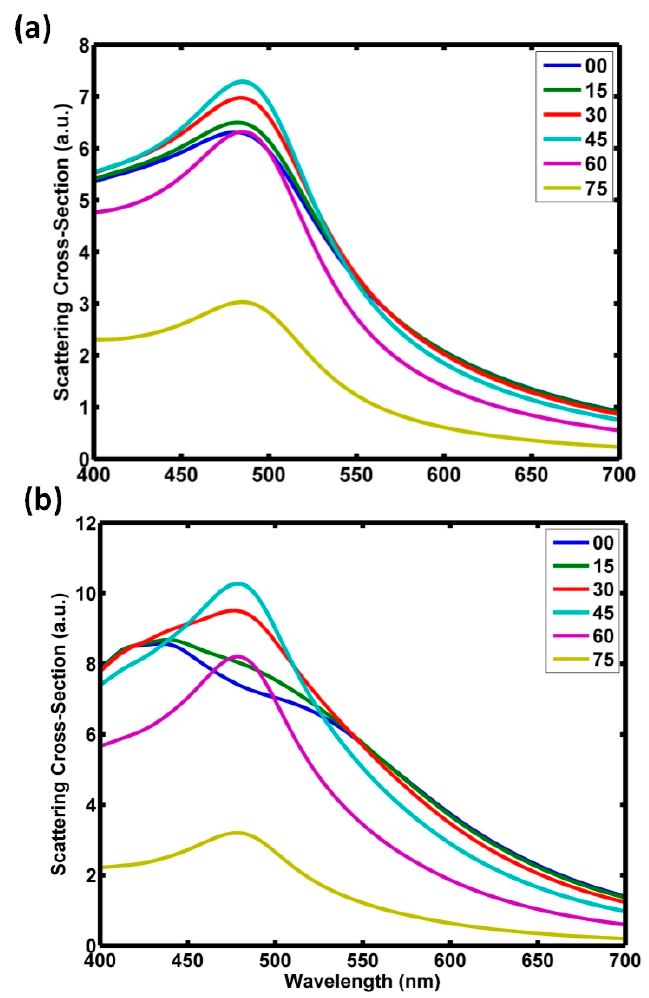
Figure 7. Scattering cross section (Q SCS ) of a Cu 2 O particle on a ( a ) glass substrate or ( b ) silicon substrate.